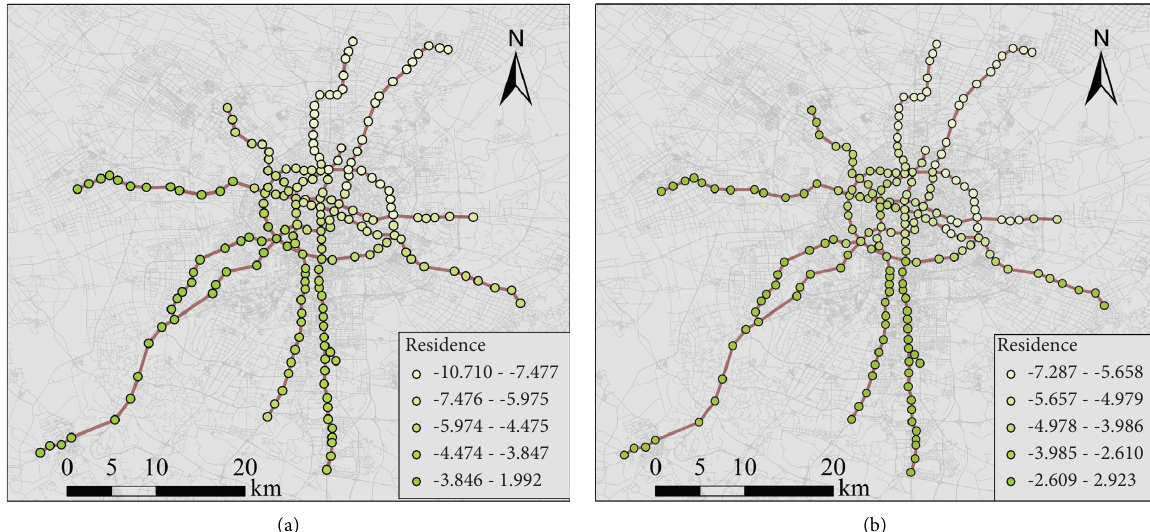
Figure 7: Spatially varying efects of residence on the access/egress distance. (a) Efects of residence on the access distance and (b) efects of residence on the egress distance.